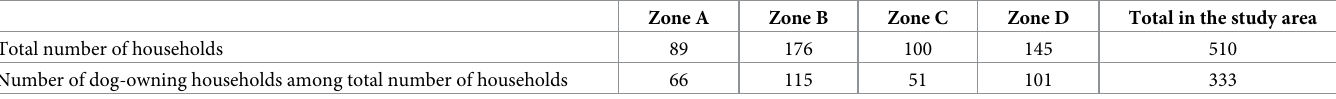
Table 2. Number of households involved in the study.